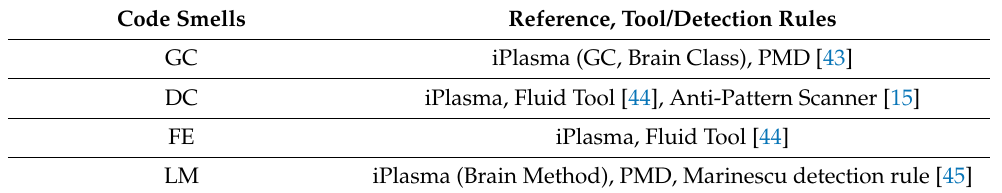
Table 2. Automatic Detector Tools and Techniques (ADVISORS)